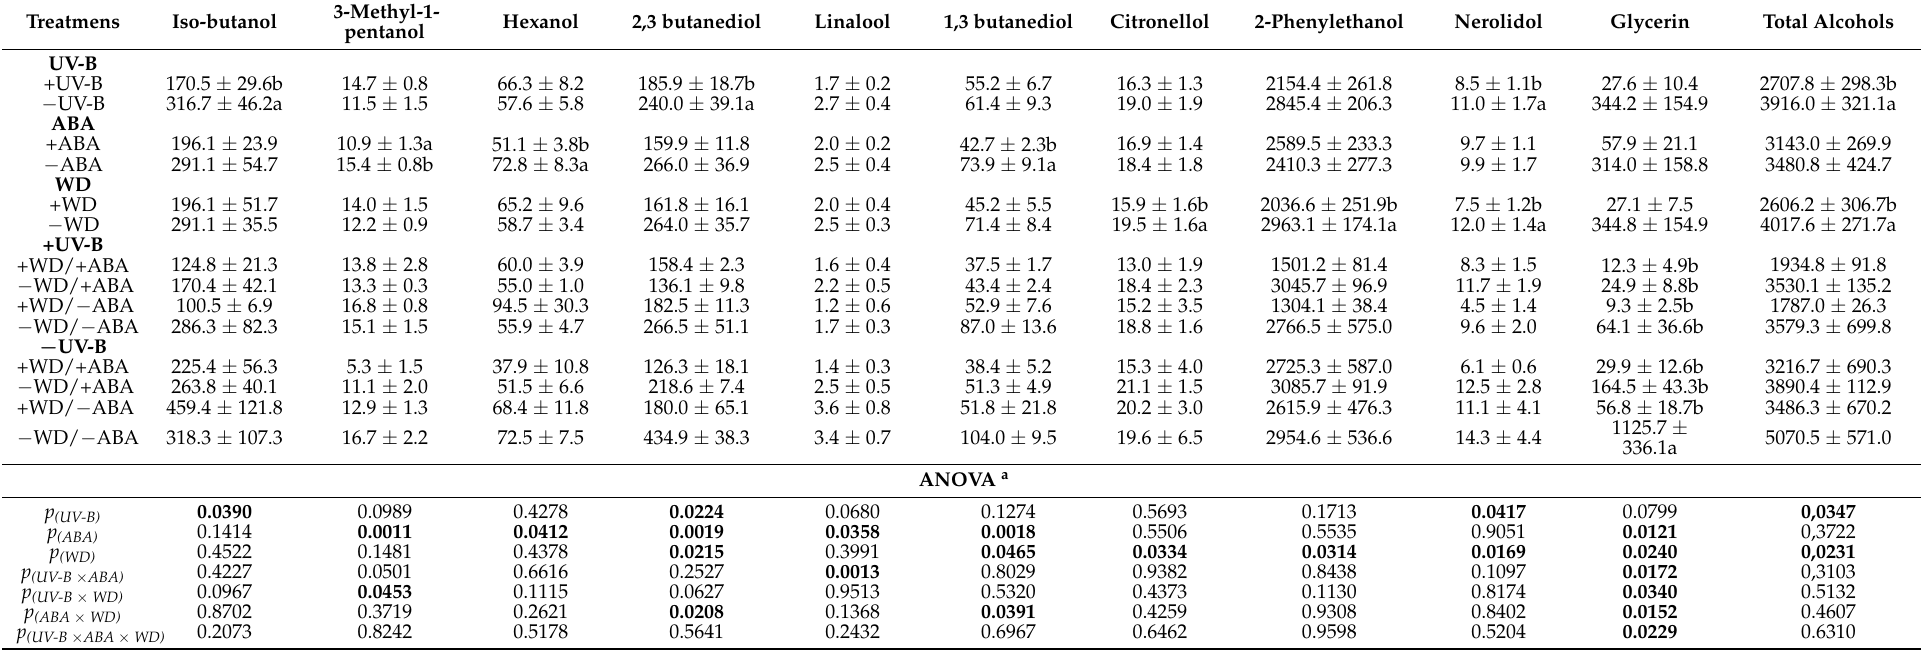
Table 4. Volatile alcohols ( µ g L − 1 ) determined in wines from Malbec plants exposed to combined UV-B, WD and ABA